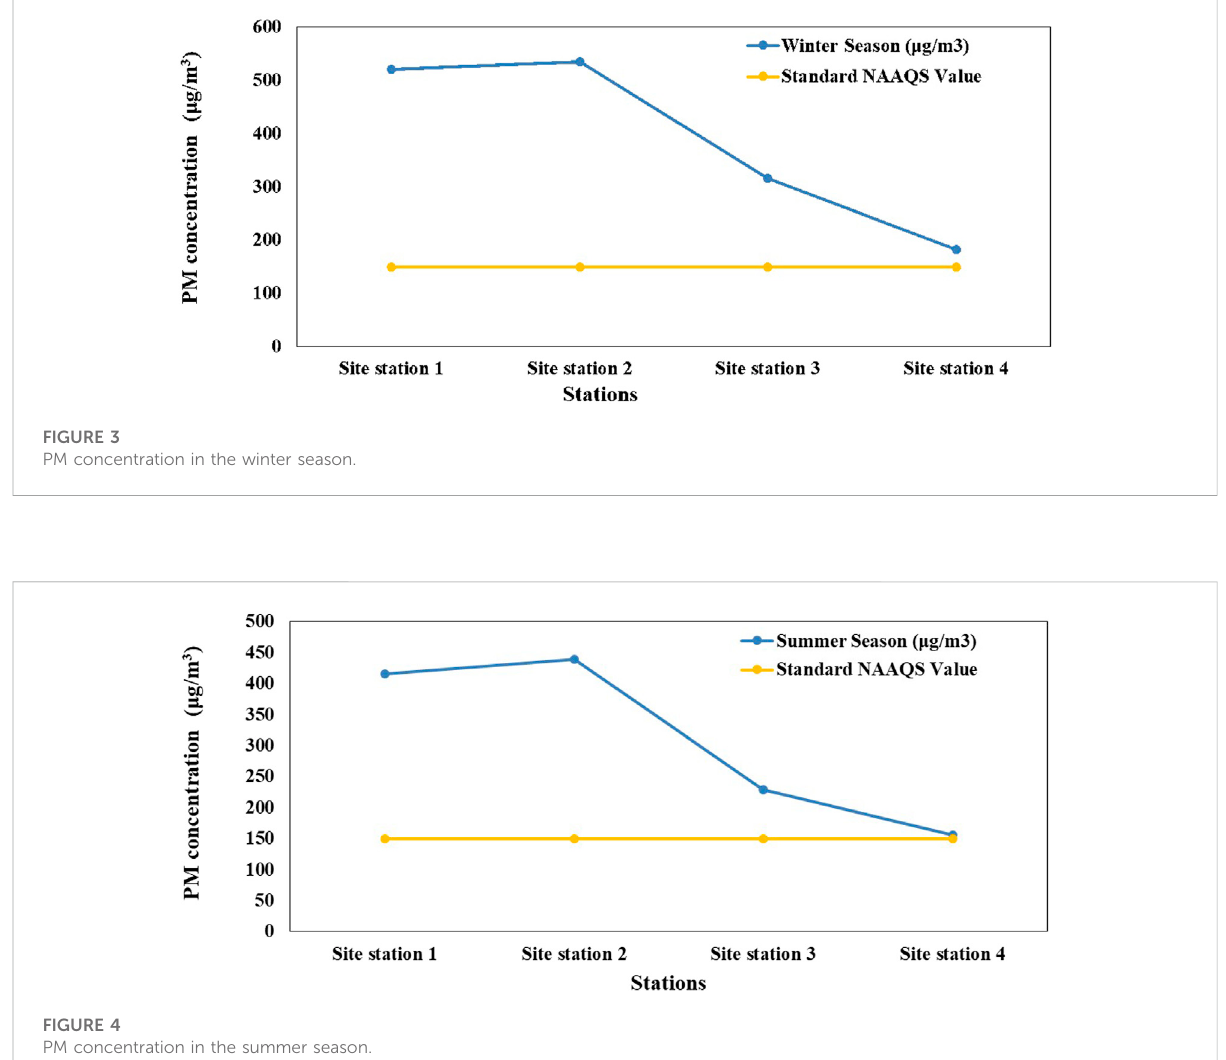
losses, electrical wiring losses, re fl ection losses, clipping losses, shading losses, inverters losses, and AC system losses. The temperature losses are 6.2%, irradiance losses are 0.4%,